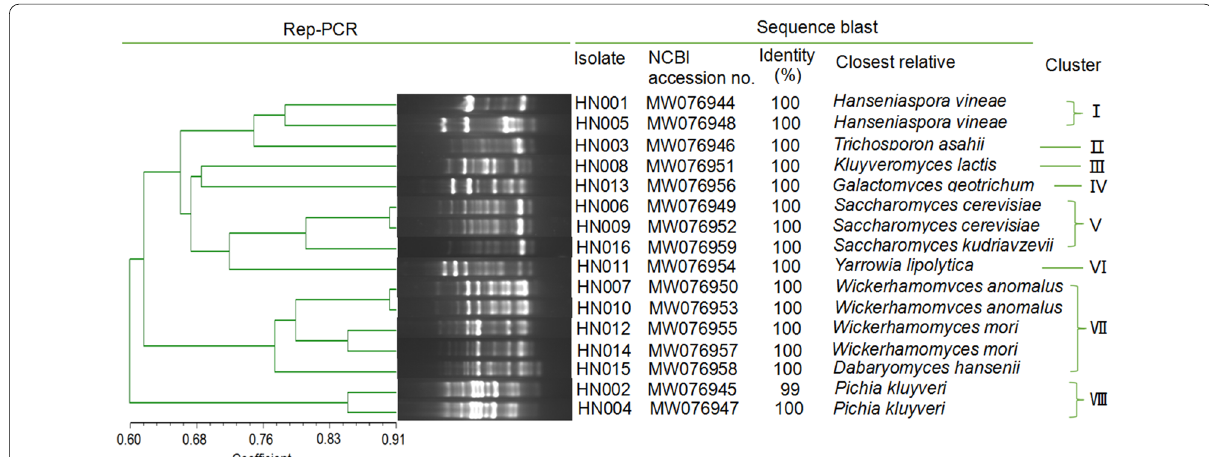
Fig. 1 Dendrogram obtained by cluster analysis of (GTG) 5 -based rep-PCR fingerprints of the isolated yeasts, based on Dice’s coefficient of similarity with the unweighted pair group method with arithmetic average clustering algorithm (UPGMA). Yeast species were identified by sequencing of 26S rRNA gene and GenBank